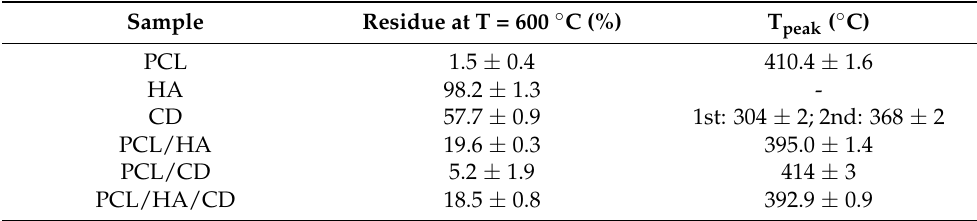
Figure 2. Thermogravimetric ( a ) and derivative ( b ) curves of pure materials and scaffolds. Table 4. Residue percentages and peak degradation temperatures obtained by TGA.